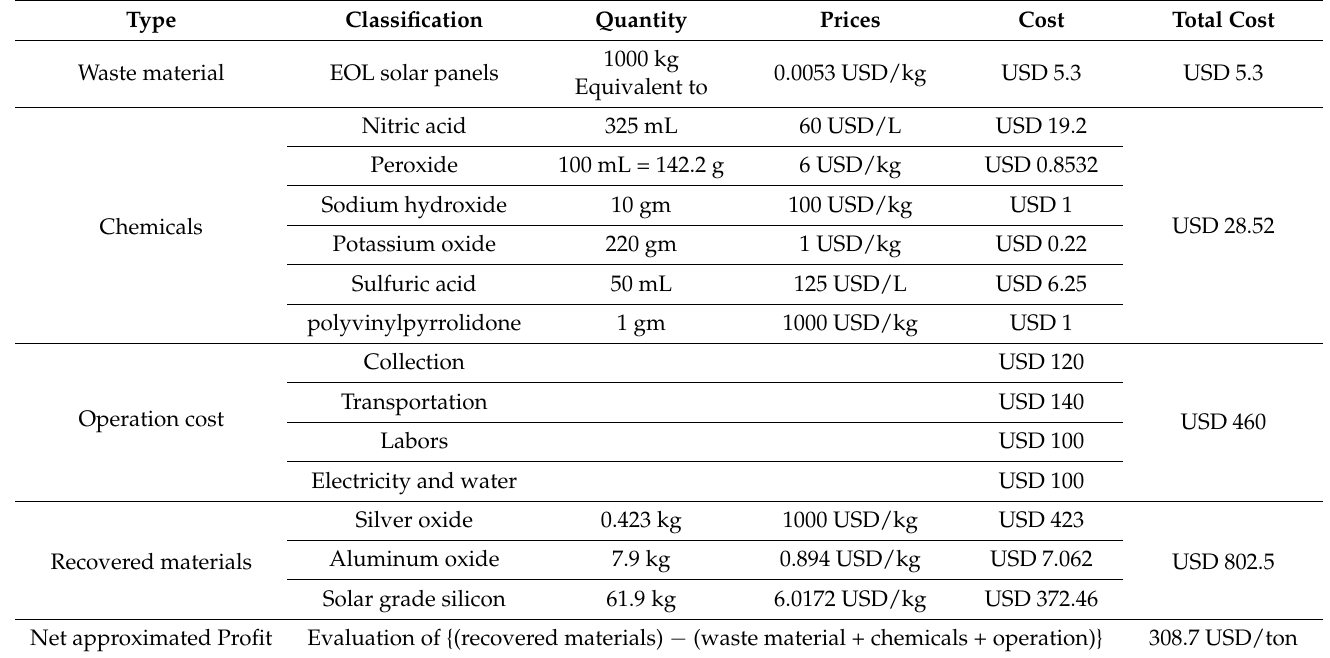
Table 3. Cost analysis treatment of one ton of EOL solar on a laboratory